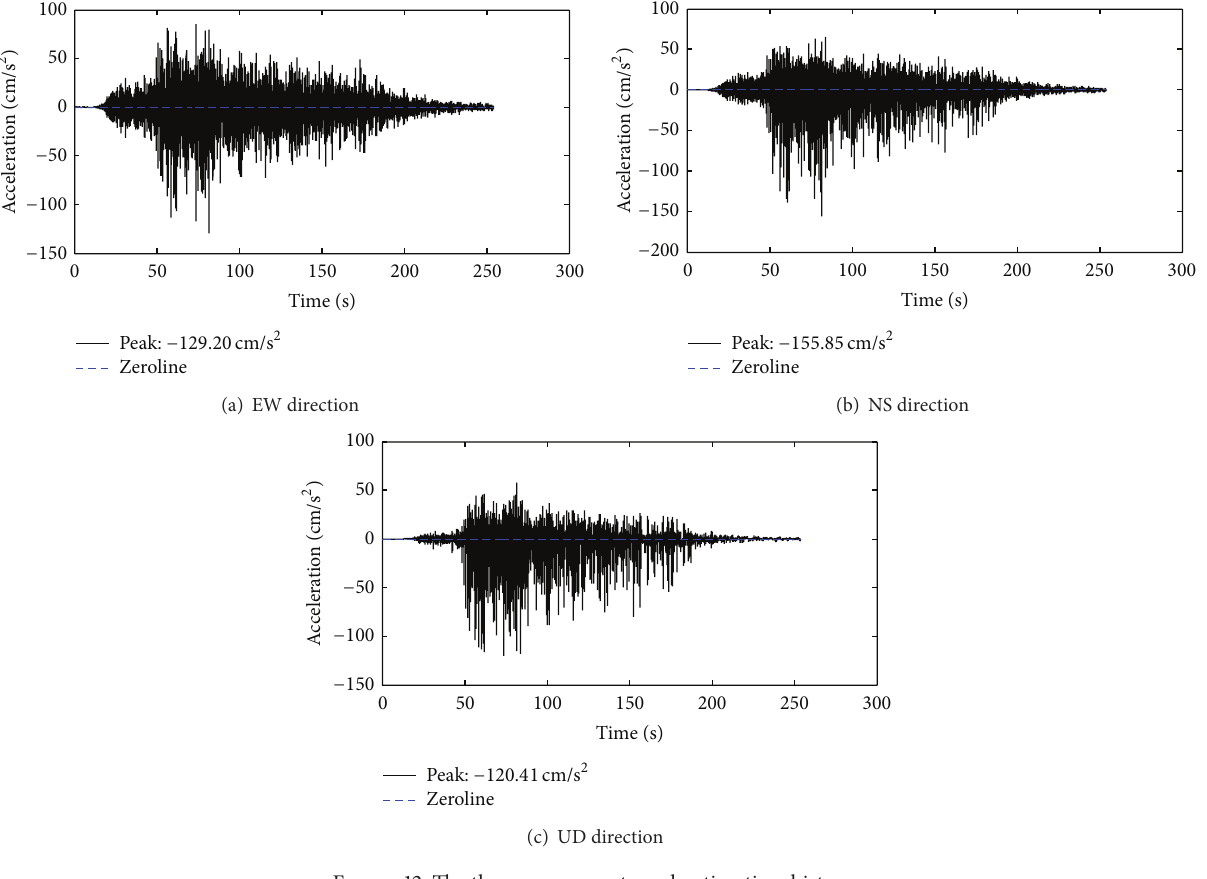
Figure 12: The three-component acceleration time